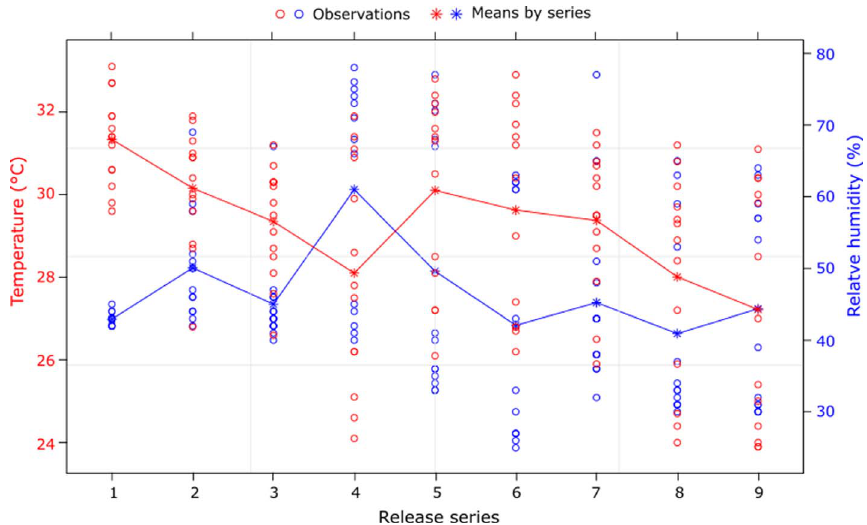
Figure 3. Variation in temperature and relative humidity in the fi eld cage during the assessment of the mating performance of irradiated